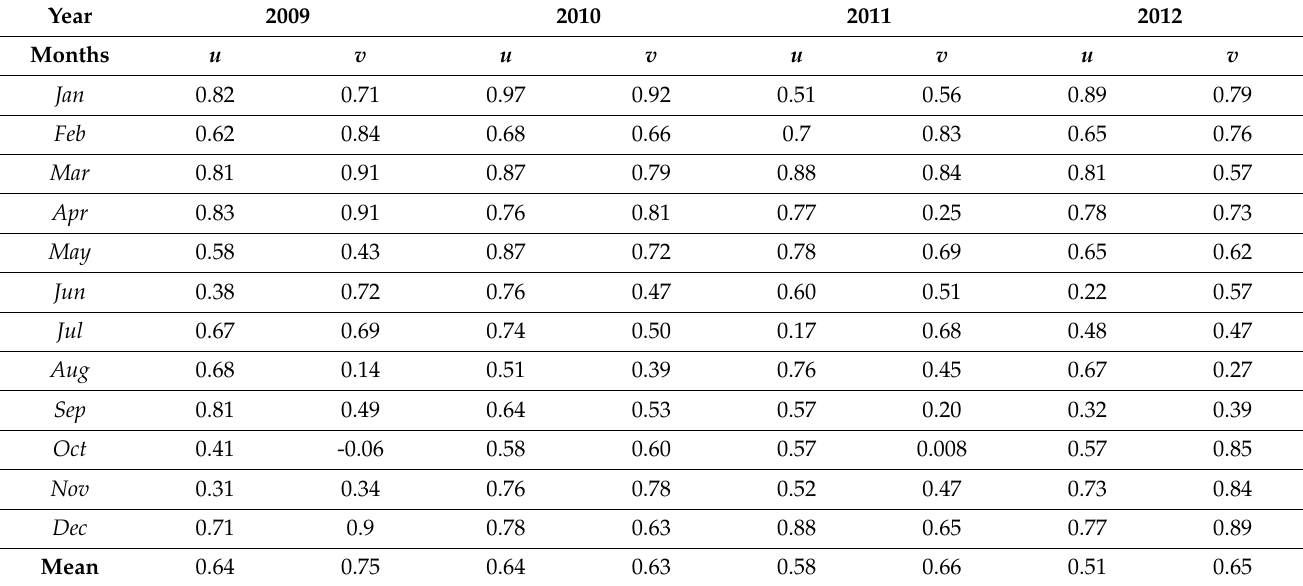
Table 1. In table are reported the ρ of GNAM and HFR current component ( u , v ) in the GoN (with 70% of coverage in HFR